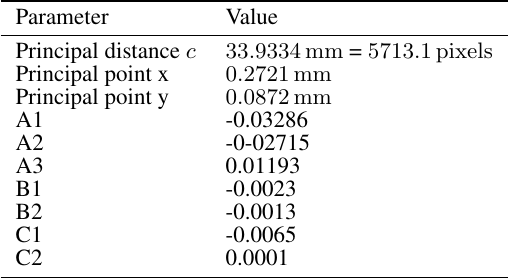
Table 1. Initial calibration values determined with AICON 3D Studio for the Nikon Z7.